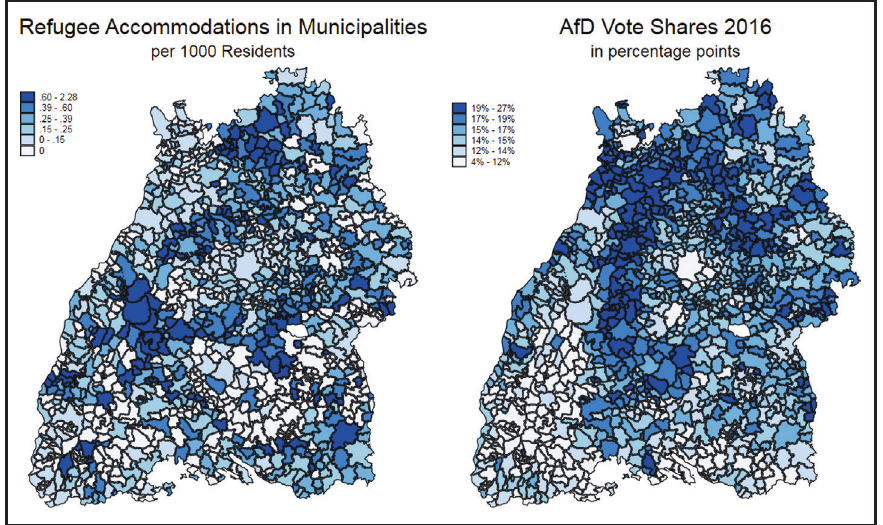
The number of refugee accommodations per 1,000 residents (left), and the AfD vote shares in 2016 in Baden-Wuerttemberg, that is, BW